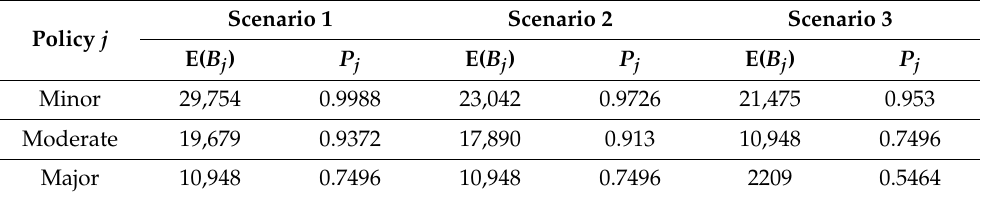
Table 9. E( B j ) and P j by incremental infection rate scenarios in